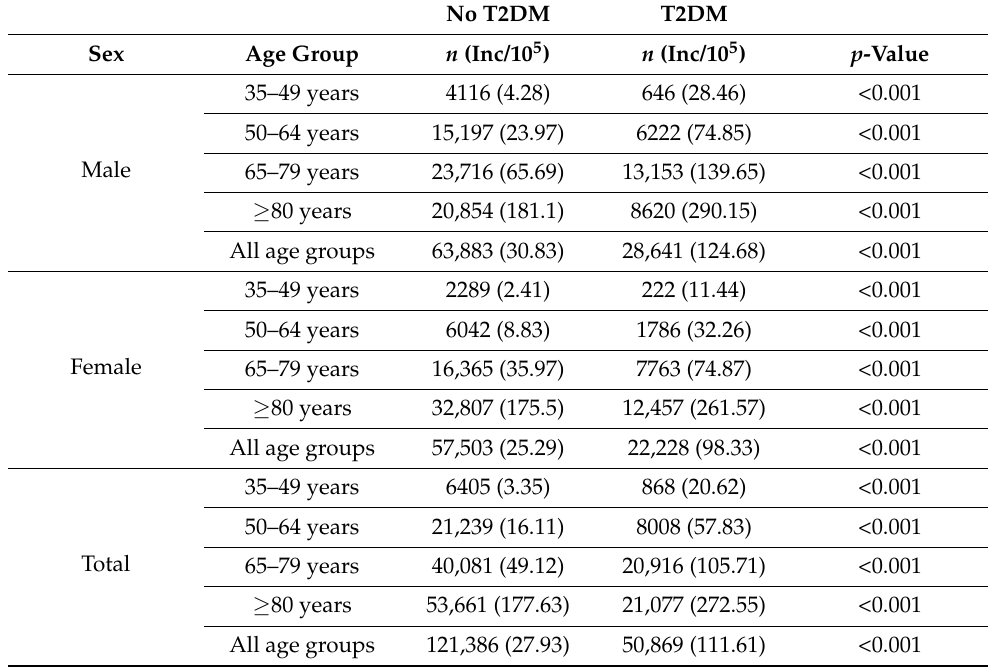
Table 1. Incidence of ischemic stroke according to presence of type 2 diabetes mellitus (T2DM), sex, and age